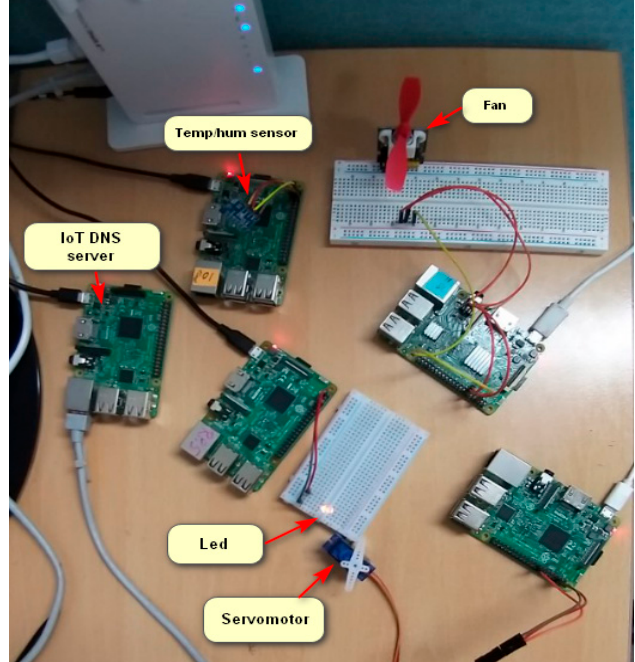
Figure 10. The testbed network environment of the IoT Domain Name System (DNS) and IoT Devices .